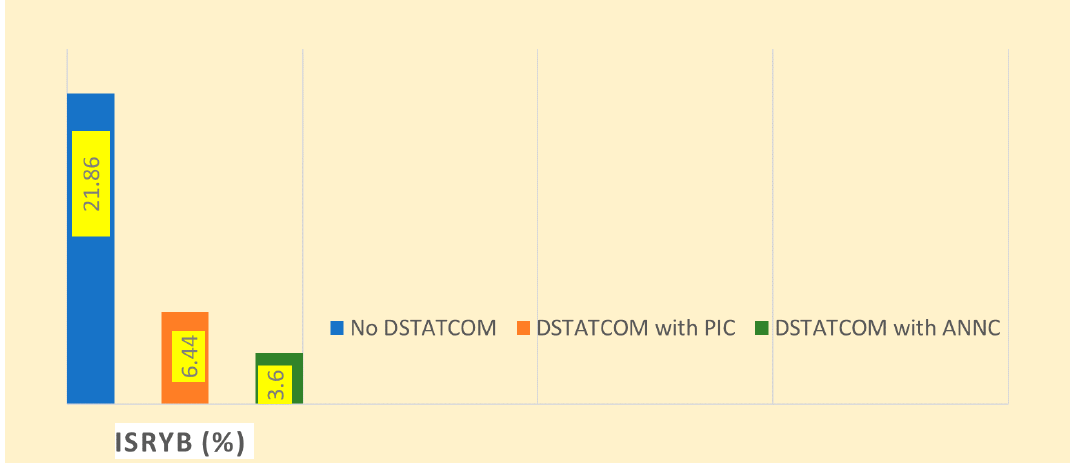
Figure 19. Source current THD using DSTATCOM with a PI Controller. Table 4. Source current THD for various conditions.